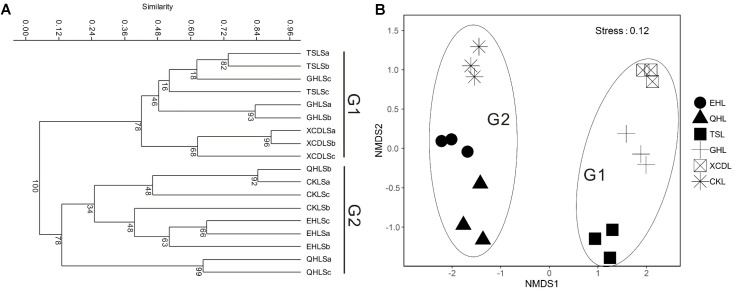
Clustering (A) and NMDS ordination (B) analysis on the basis of Bray-Curtis dissimilarities among the studied lake samples. G1: the group of samples from lakes in the Qaidam Basin hinterland; G2: the group of samples from the fringe (CKL) and out (EHL and QHL) of the Qaidam Basin.